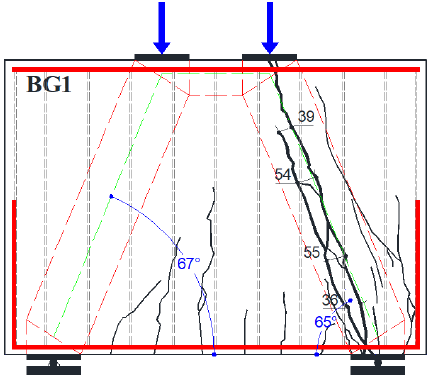
Figure 26: Crack pattern and mode of failure for horizontal web reinforcement only with ratio 0.40%